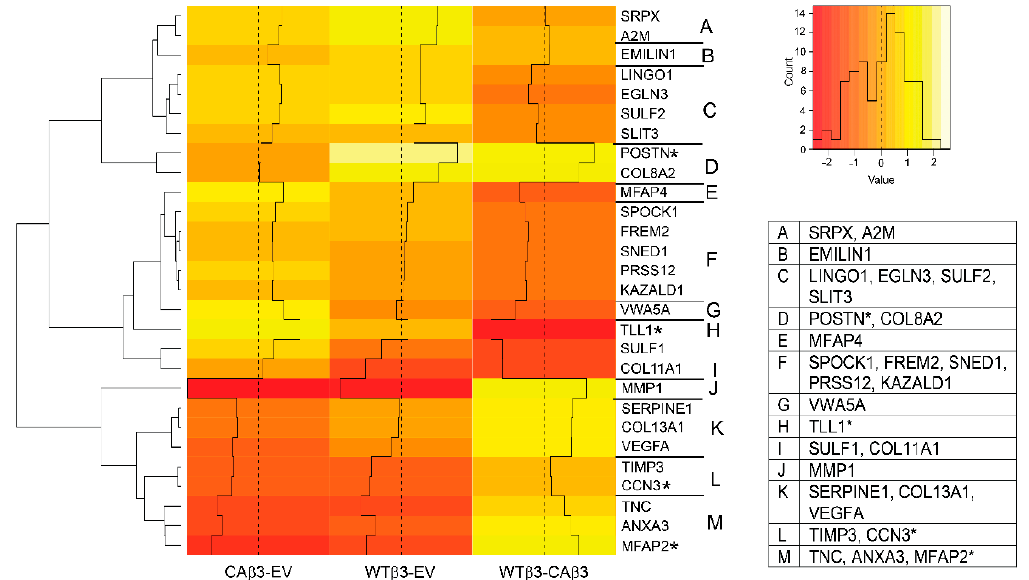
Figure 5. Hierarchical clustering of ECM-associated genes finds differential gene expression in WT β 3 and CA β 3 cells relative to control EV cells and to each other. Genes from each of the three contrasts analyzed for DGE that met the Log 2 FC ± 1.5 cutoff and were classified as encoding either core ECM proteins, ECM-associated proteins or matricellular proteins were analyzed as in Figure 4. A heat map displaying standardized z-scores was generated. The clusters identified by letters on the right side of the map were determined manually. Genes within each of these clusters are listed in the displayed table. Those genes highlighted by an asterisk represent genes that had been dealt with as described for Figure 4.